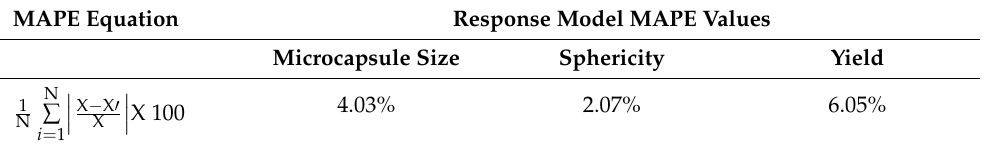
Table 5. Mean Absolute Percentage Error (MAPE) Analysis of the Response